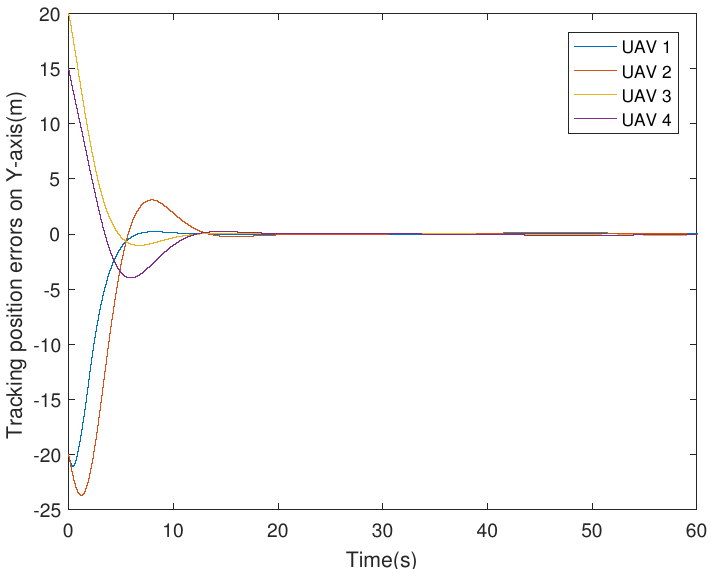
Figure 4. Responses of formation tracking error on Y-axis.